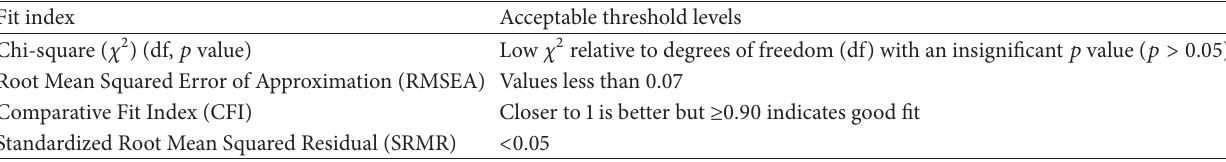
Table 2: Some selected model fit indices and their cut-off points